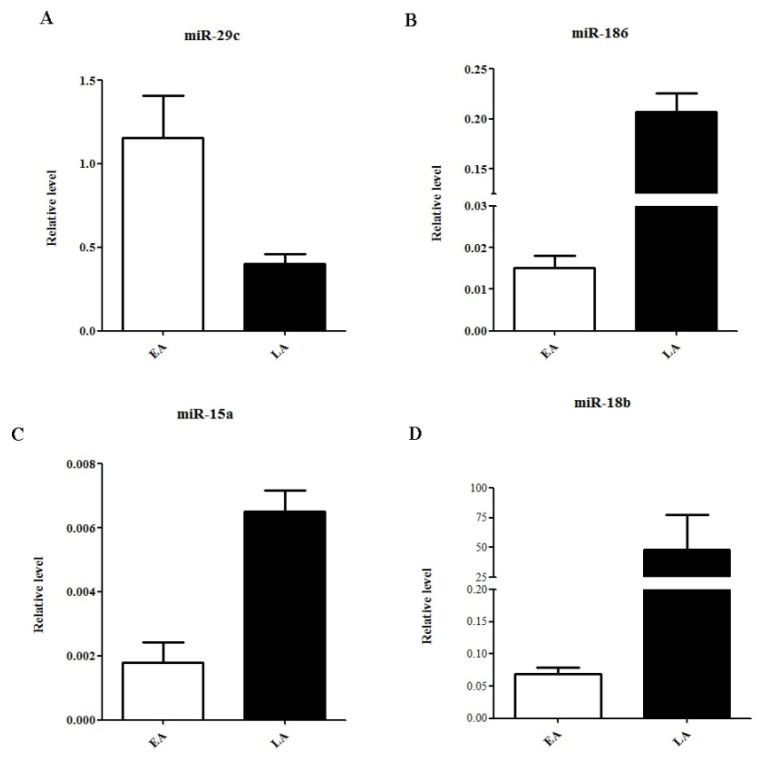
qRT-PCR validation of four select miRNAs. Relative expression of miR-29c (A), miR-186 (B), miR-15a (C), and miR-18b (D) in early (EA) and late (LA) recurrent HCC samples. Data are normalized to levels of β-actin. p-Value < 0.05 in all miRNAs.